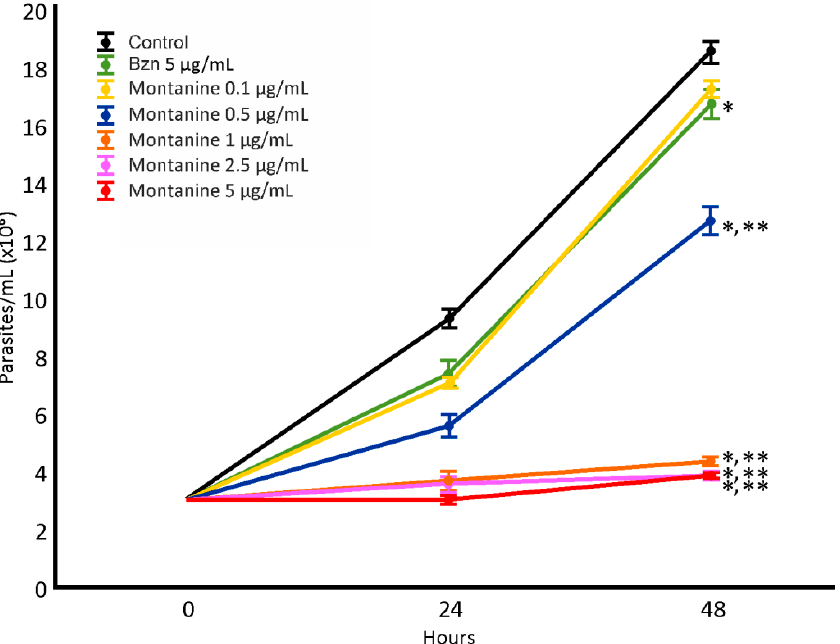
Figure 3. Effect of montanine in T. cruzi epimastigotes. *: Significant difference from negative control; **: significant difference from positive control. p < 0.05.